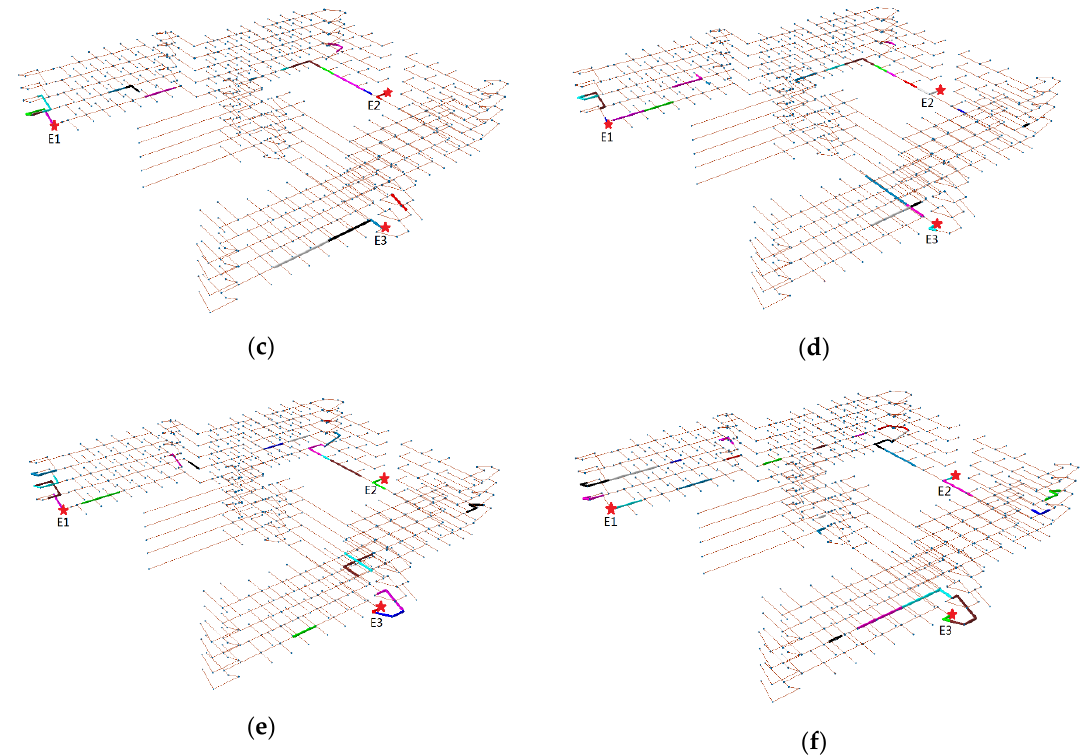
Figure 15. The simulation of partitioned and staged evacuation for the multi-exit network. Six screenshots are given at different times as follows: ( a ) t0 + 32 s; ( b ) t0 + 64 s; ( c ) t0 + 112 s; ( d ) t0 + 144 s; ( e ) t0 + 232 s; ( f ) t0 + 272 s.